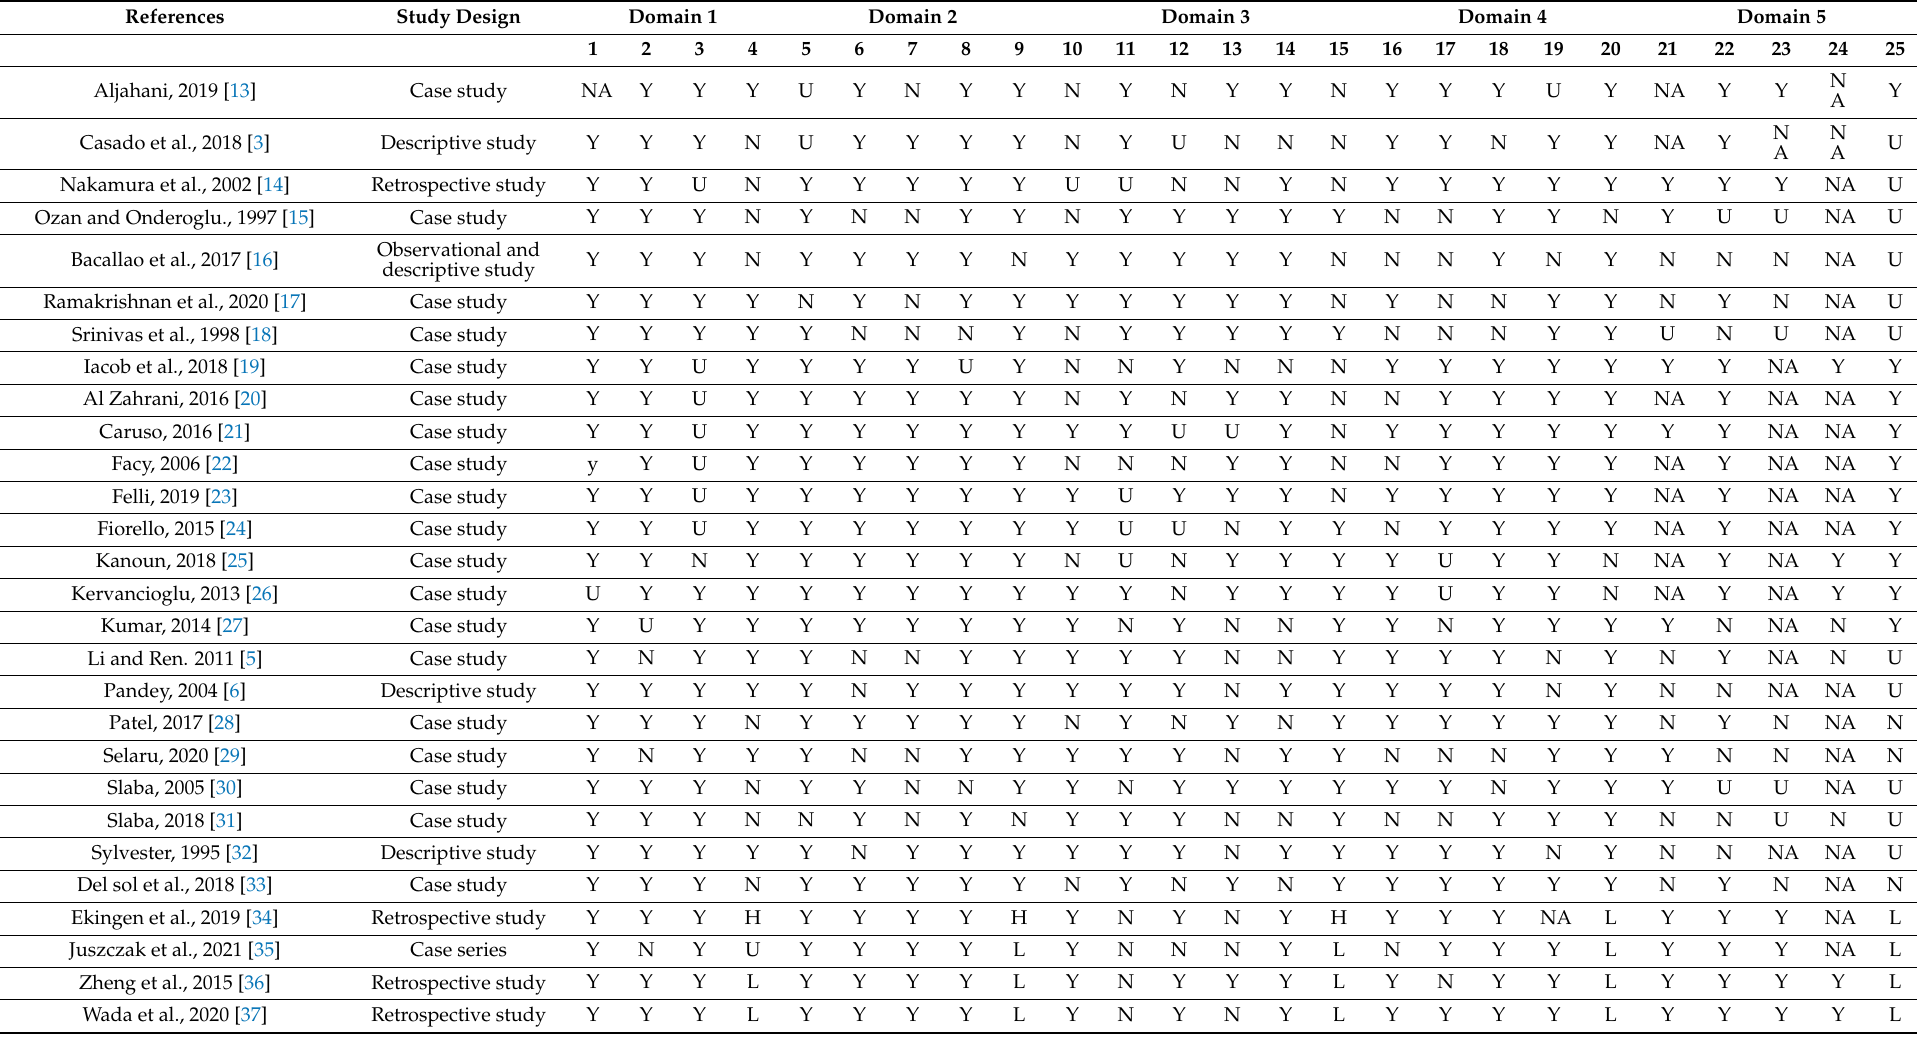
Table 2. Details of the application and assessment of the AQUA